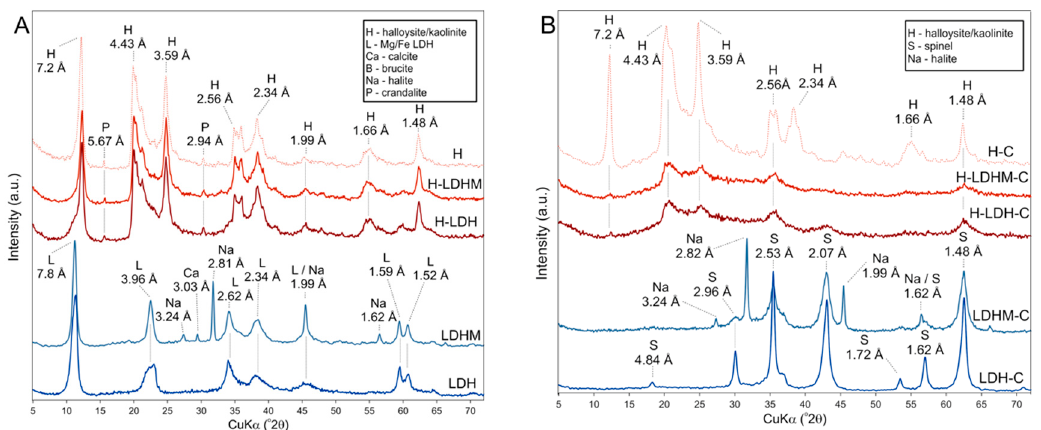
Figure 1. X-ray diffraction (XRD) patterns of ( A ) uncalcined and ( B ) calcined